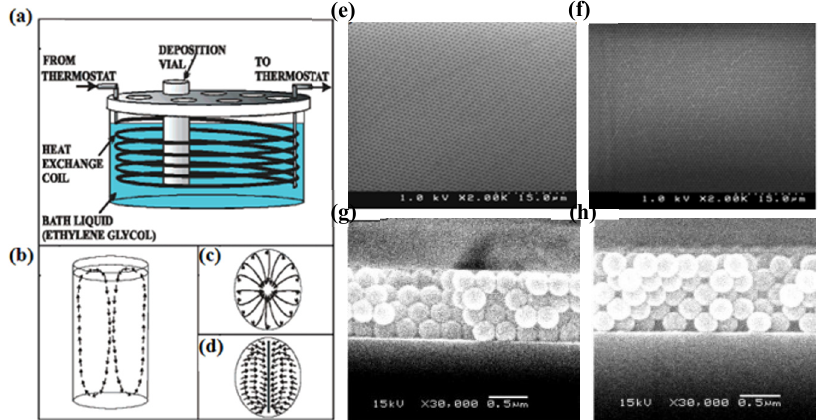
Figure 5. ( a ) Diagram of the isothermal bath device for the deposition of colloidal crystal film. ( b – d ) Representation of a convection pattern in a vial immersed in a bathtub. ( b ) Side view, ( c ) top view, and ( d ) top view when the slide is inserted into the center of the vial. ( e , f ) SEM image of a top view of the silica gel film, which shows that the prepared film achieved a high degree of sequencing. ( e ) 480 nm, ( f ) 850 nm [43]. Copyright 2003, Journal of the American Chemical Society . ( g , h ) Cross-sectional SEM images of polystyrene. ( g ) − 10 ◦ , ( h ) 0 ◦ [44]. Copyright 2003, Chemistry of Materials .